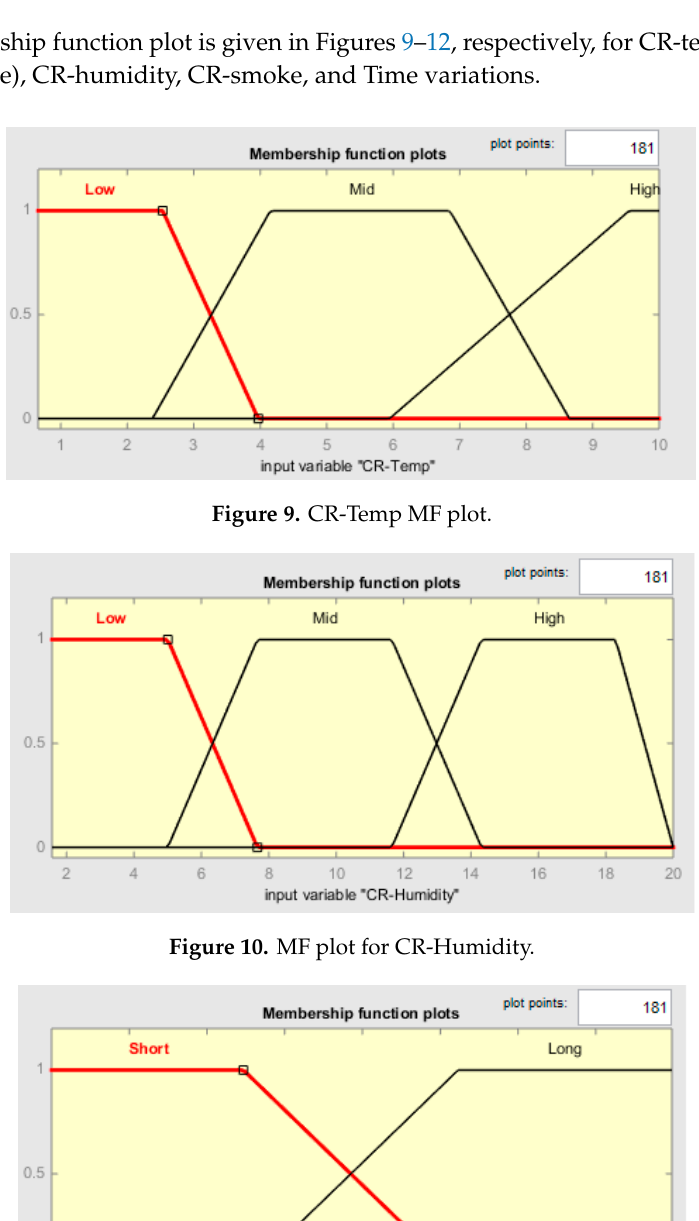
Figure 11. MF plot for